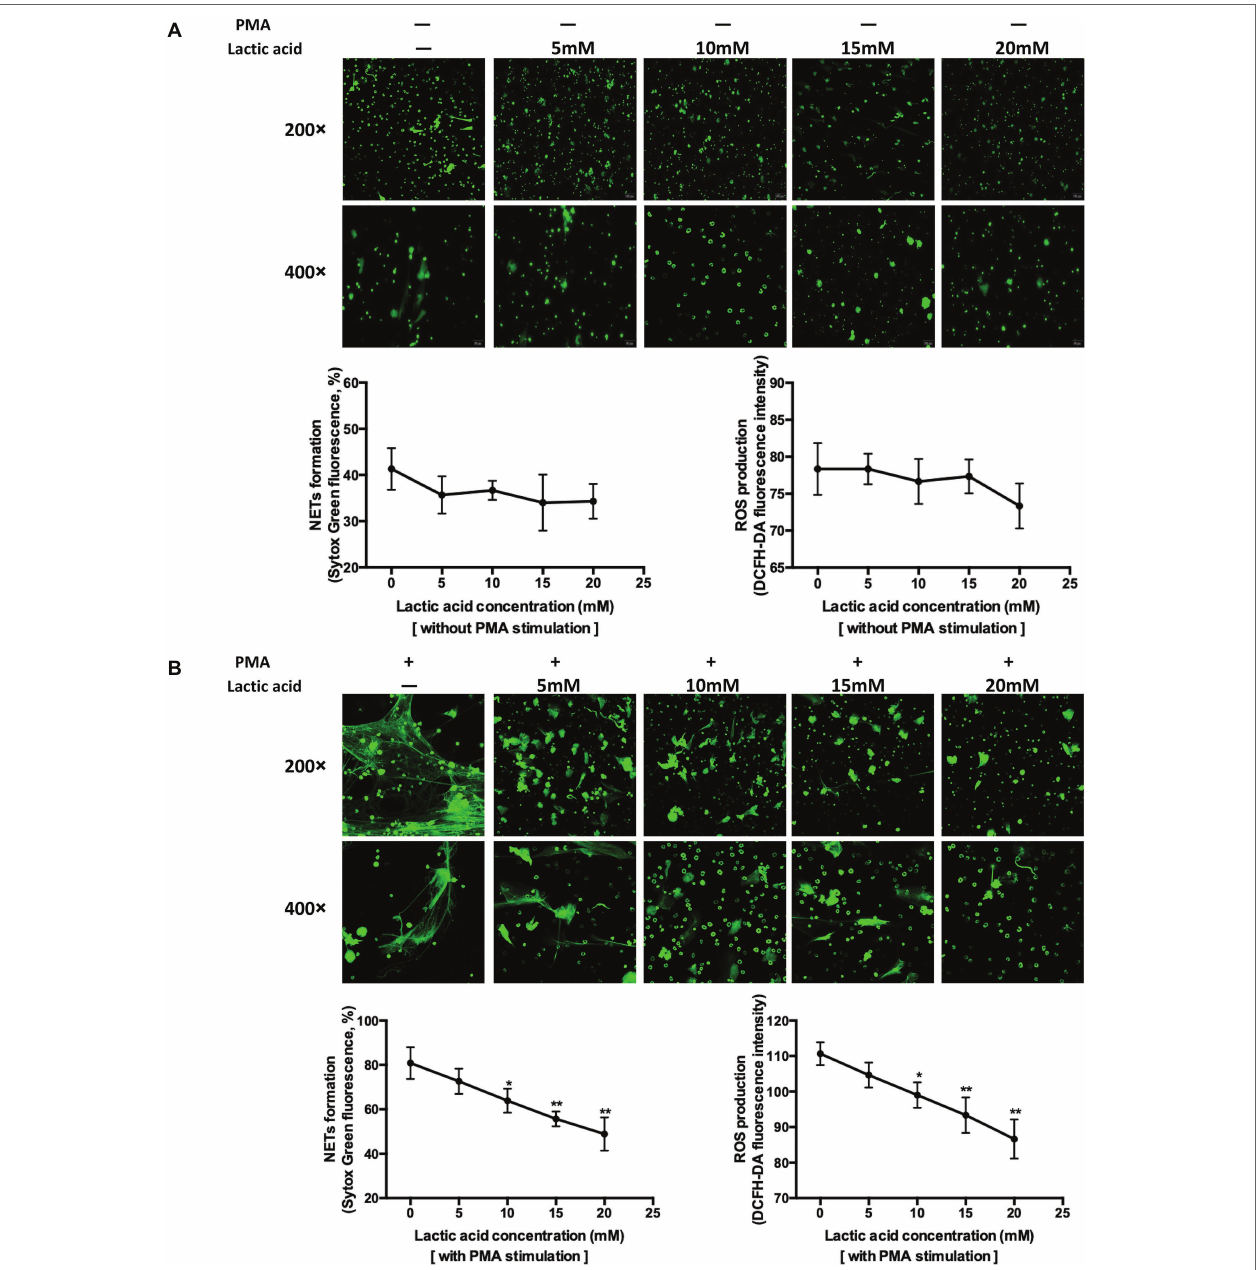
FIGURE 3 | Increasing levels of lactic acid attenuated neutrophil extracellular traps release through inhibition of ROS production using in vitro methods. (A) Fresh neutrophils isolated from mouse bone marrow were seeded into 96-well plate and treated with media only, 5, 10, 15, and 20 mM lactic acid, respectively, for 4 h. The first row shows the structure of extracellular traps stained with SytoxGreen at a magnification of 200×. The second row is at a magnification of 400×. Extracellular DNA stained with SytoxGreen was hemi-quantified using a fluorescence microplate reader which indirectly represents NETs release. Intracellular ROS was detected with a cell probe and quantified using a fluorescence microplate reader at 480 nm excitation and 520 nm emission wavelength. The curve represents mean values (with SEM) with 100 nM PMA plus five different lactic acid concentrations (0, 5, 10, 15, 20 mM). * indicates p < 0.05, ** indicates p < 0.001, *** indicates p < 0.005, **** indicates p < 0.0001. (B) Neutrophils were seeded and treated with 100 nM PMA, 100 nM PMA plus 5, 10, 15, and 20 mM lactic acid, respectively, for 4 h. The curve represents mean values (with SEM) with 100 nM PMA plus five different lactic acid concentrations (0, 5, 10, 15, 20 mM). * indicates p < 0.05, ** indicates p <